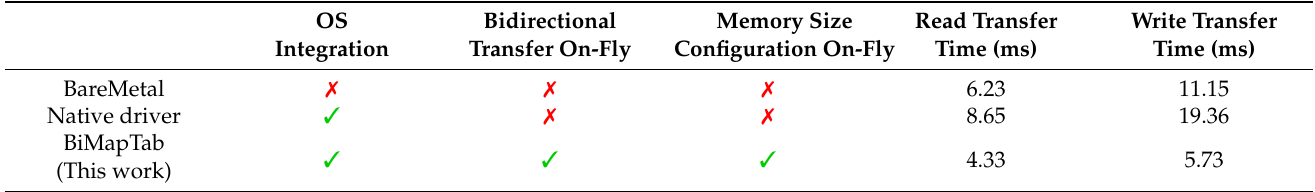
Table 2. Comparison with existing mechanism for AXI-DMA transfers on Xilinx PSoC and MPSoC